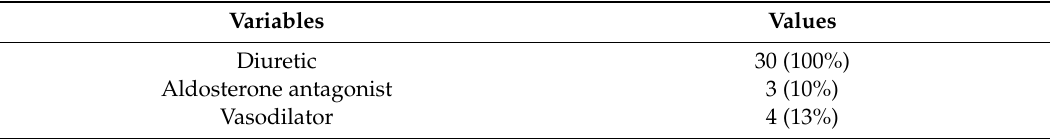
Table 1. Cont. Variables Values Diuretic 30 (100%) Aldosterone antagonist 3 (10%)